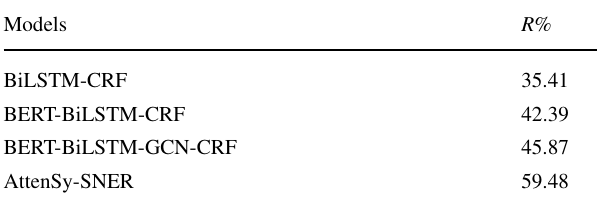
Fig. 8 Comparison of experimental results of different models Table 8 Results of out-of-vocabulary entity recognition